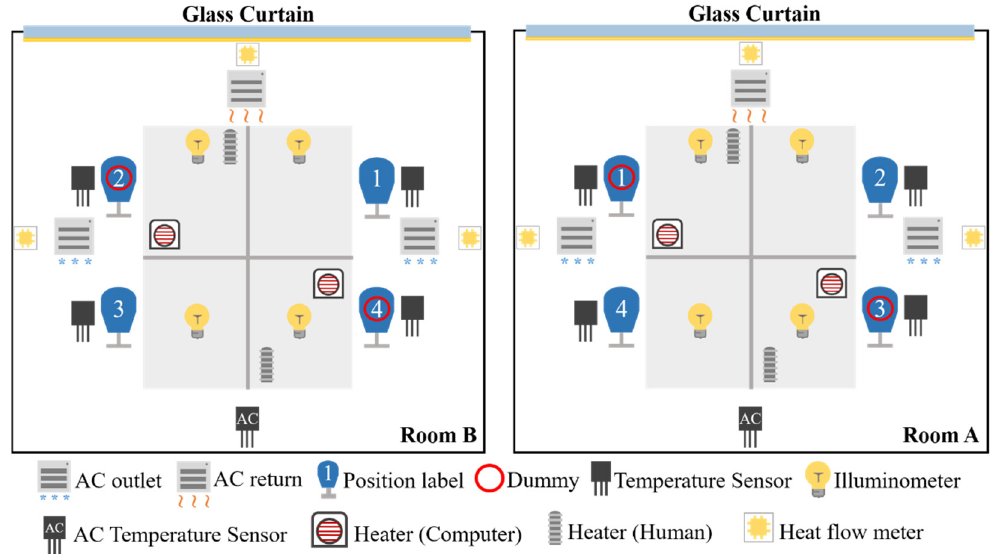
Figure 2. Laboratory internal configuration.